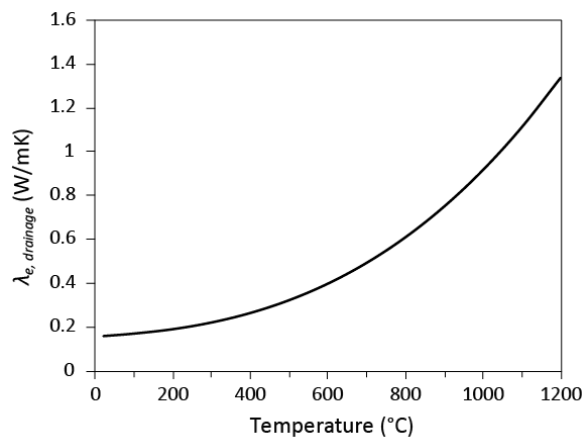
Figure 7. E ff ective thermal conductivity of the drainage layer. Figure 7. Effective thermal conductivity of the drainage layer.